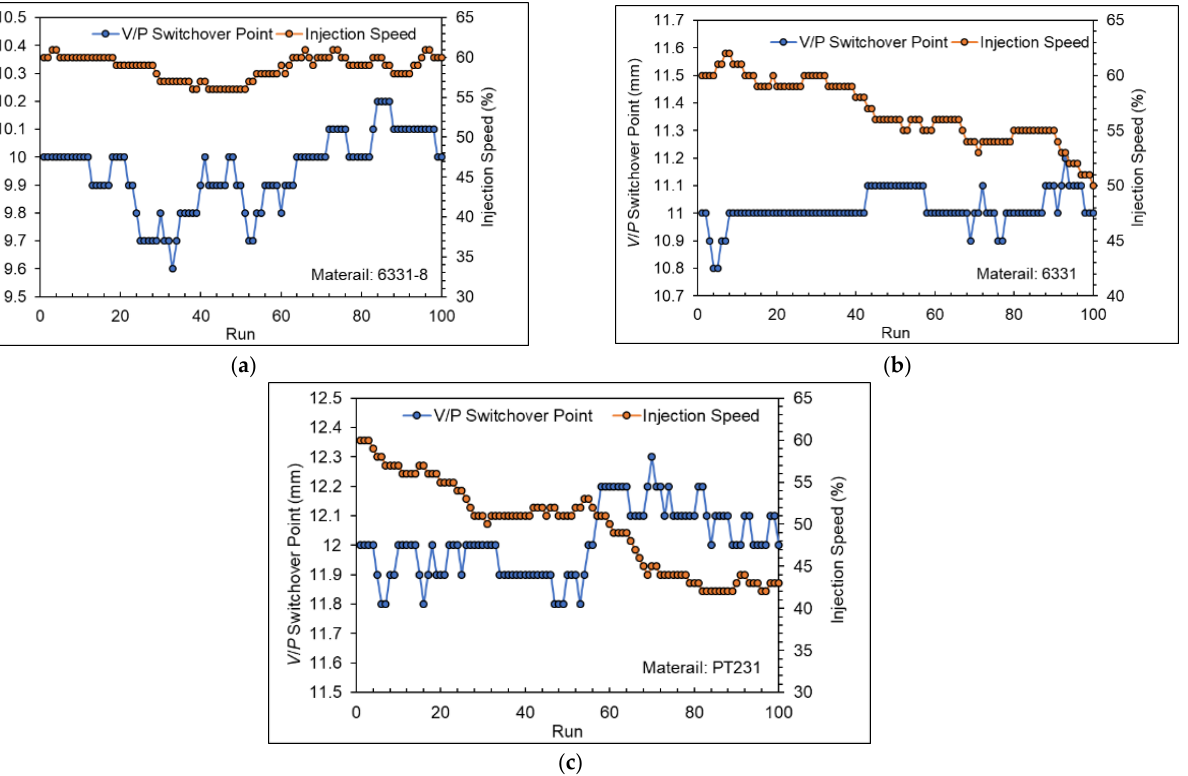
Figure 26. Adjustment process of the adaptive process control system (( a ) 6331 − 8, ( b ) 6331, and ( c ) PT231).